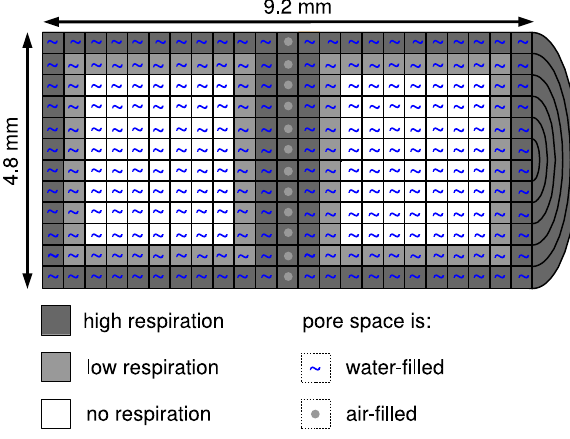
Fig. 3. The setup of the cylinder which represents a soil aggregate in our model. The porosity is uniformly distributed ( φ = 0.3). The pores in the middle slice are air-filled, the rest of the pore-space is water-filled. Respiration takes place in the outer shell of the cylinder, in the aerated slice, and close to the aerated slice.